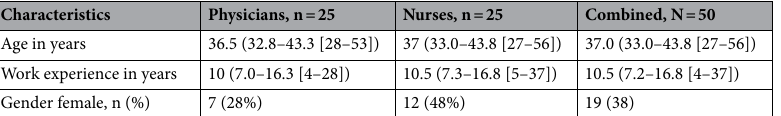
Table 1. Participant characteristics (N = 50). Values are numbers (proportion) or median (IQR 29 ). We counted the years after university graduation (physicians) or nursing education (nurses) as work experience. IQR interquartile